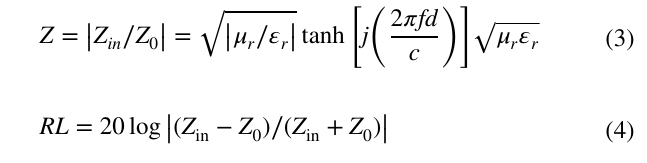
OMCS-40 are heavily intertwined, while their tan δ ε values are larger than that of ZnO/OMCS-20 in most of the fre- quency range. This provides the clear evidence that the uni- formly distributed ultrafine ZnO NPs are helpful to enhance the dielectric loss ability. Meanwhile, resonant peaks were observed in the ε ″ curves of ZnO/OMCS nanocomposites. The resonant peaks can be ascribed to the interfacial polari- zation and dipole polarization at 2–18 GHz. According to Debye relaxation theory, the relation between ε ′ and ε ′′ fol- lows Eq. 2 [52].